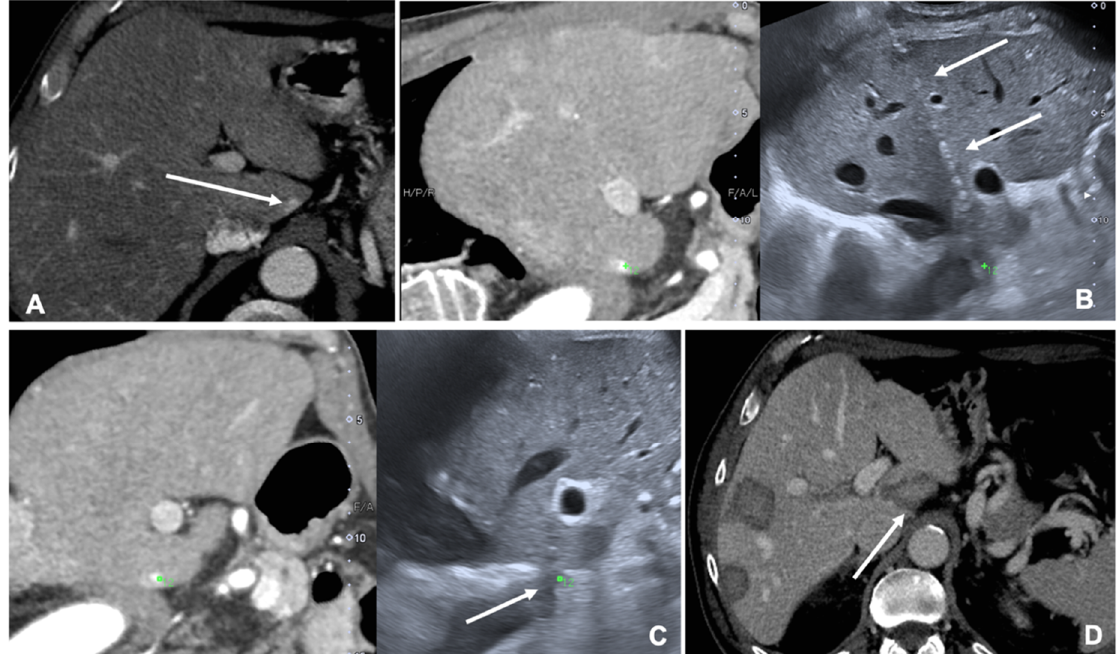
Figure 2. Case of a patient with liver metastases from renal cancer treated with microwave ablation (MWA). ( A ) Axial view during portal phase of the preoperative contrast enhanced Computed Tomography (CECT) showing a 6 mm enhancing lesion of segment I (white arrow); ( B ) Live multiplanar reconstruction of the same source CT (left side) using fusion imaging (FI) with intraoperative ultrasound (right side). In both views target lesion is marked by a green spot while the MWA needle is marked by two solid arrows in the ultrasound image (right). ( C ) FI during MWA of the lesion in the liver segment I. Arrow points out the area of gas formation at the tip of the ablation needle. ( D ) An axial view of the CECT control the day after the procedure. Arrow points out the area of ablation of the liver segment I.